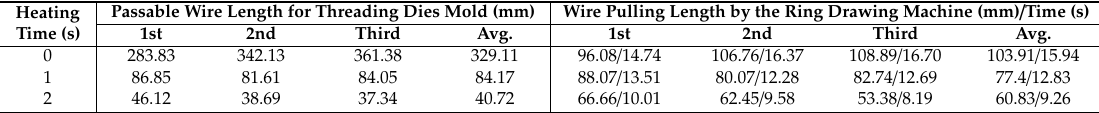
Table 3. Results based on wire pulling speed: k3(6.52 mm / s).